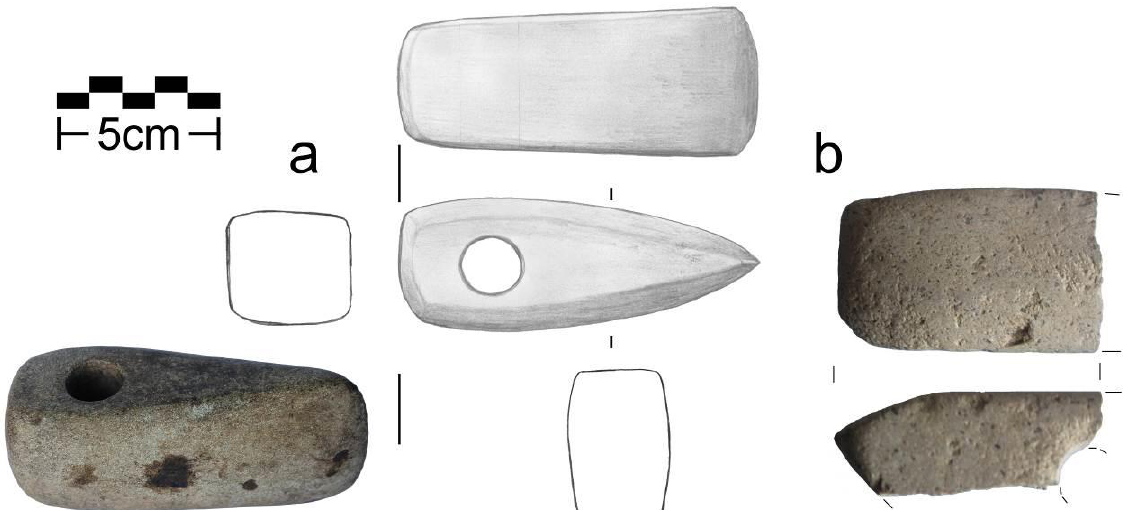
Figure 8. Polished and perforated stone axes from Răcătău. a) An intact axe from the location named Tău lui Anghel. b) A fragmented axe from Piatra Tomii Hill. Both artefacts are pictured at the same